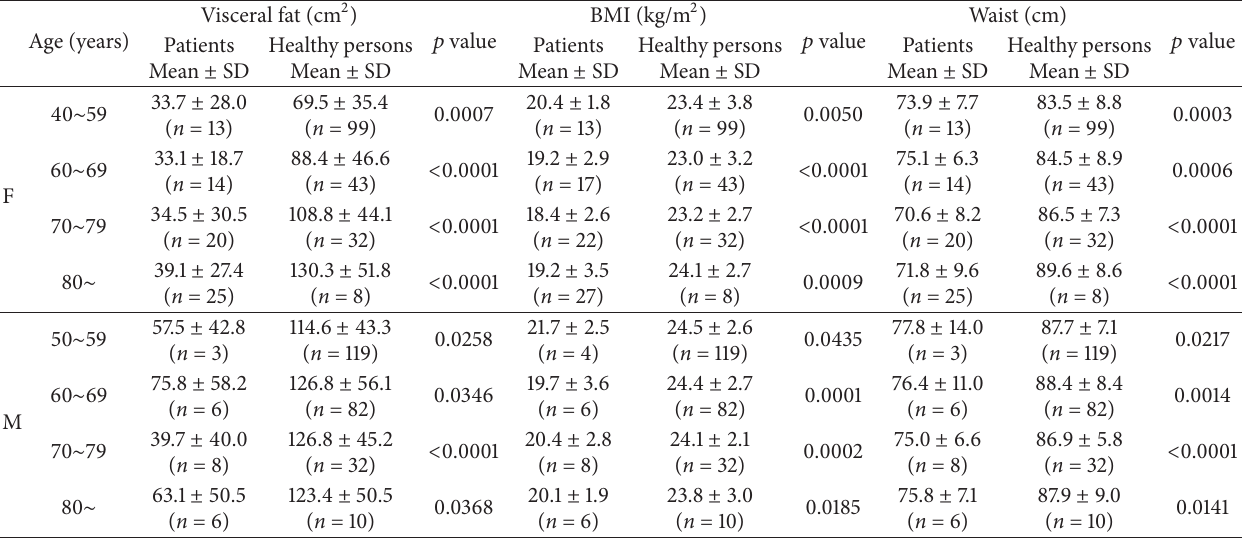
Table 2: Visceral fat, body mass index, and waist circumference of patients with MAC lung disease according to age ( 𝑛 = 103 ). Age